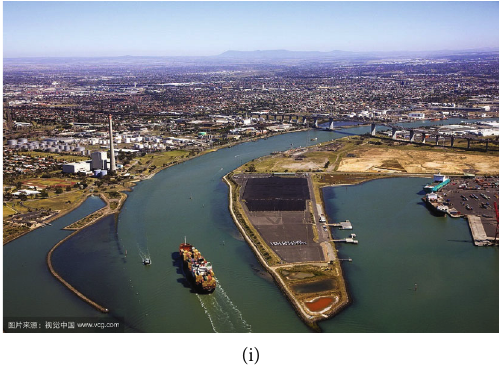
Figure 8: Comparison experiment of di ff erent methods on synthetic hazy images in Inland waterway. From top-left to bottom-right: (a) synthetic hazy image and restored images, generated by (b) DCP [19], (c) nonlocal [37], (d) F-LDCP [20], (e) AODNet [25], (f) GCANet [26], (g) MSCNN [24], (h) ours, and (i) ground truth,